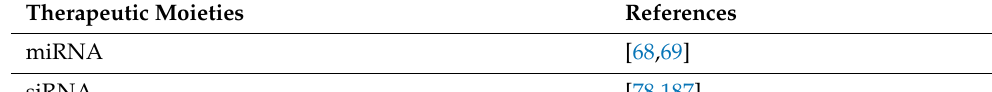
Table 3. NP surface moieties with therapeutic effects. Therapeutic Moieties